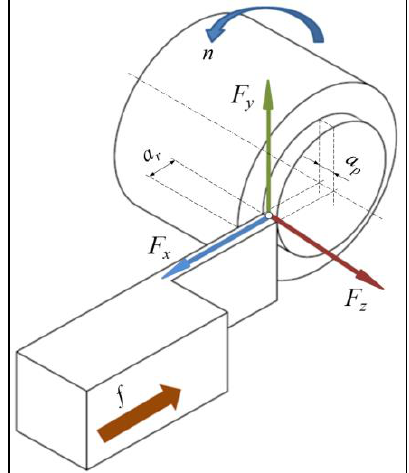
Figure 1: Schematic representation of the orthogonal components of machining force in single grooving (SG): cutting force ( F y ), feed force ( F x ), and passive force ( F z